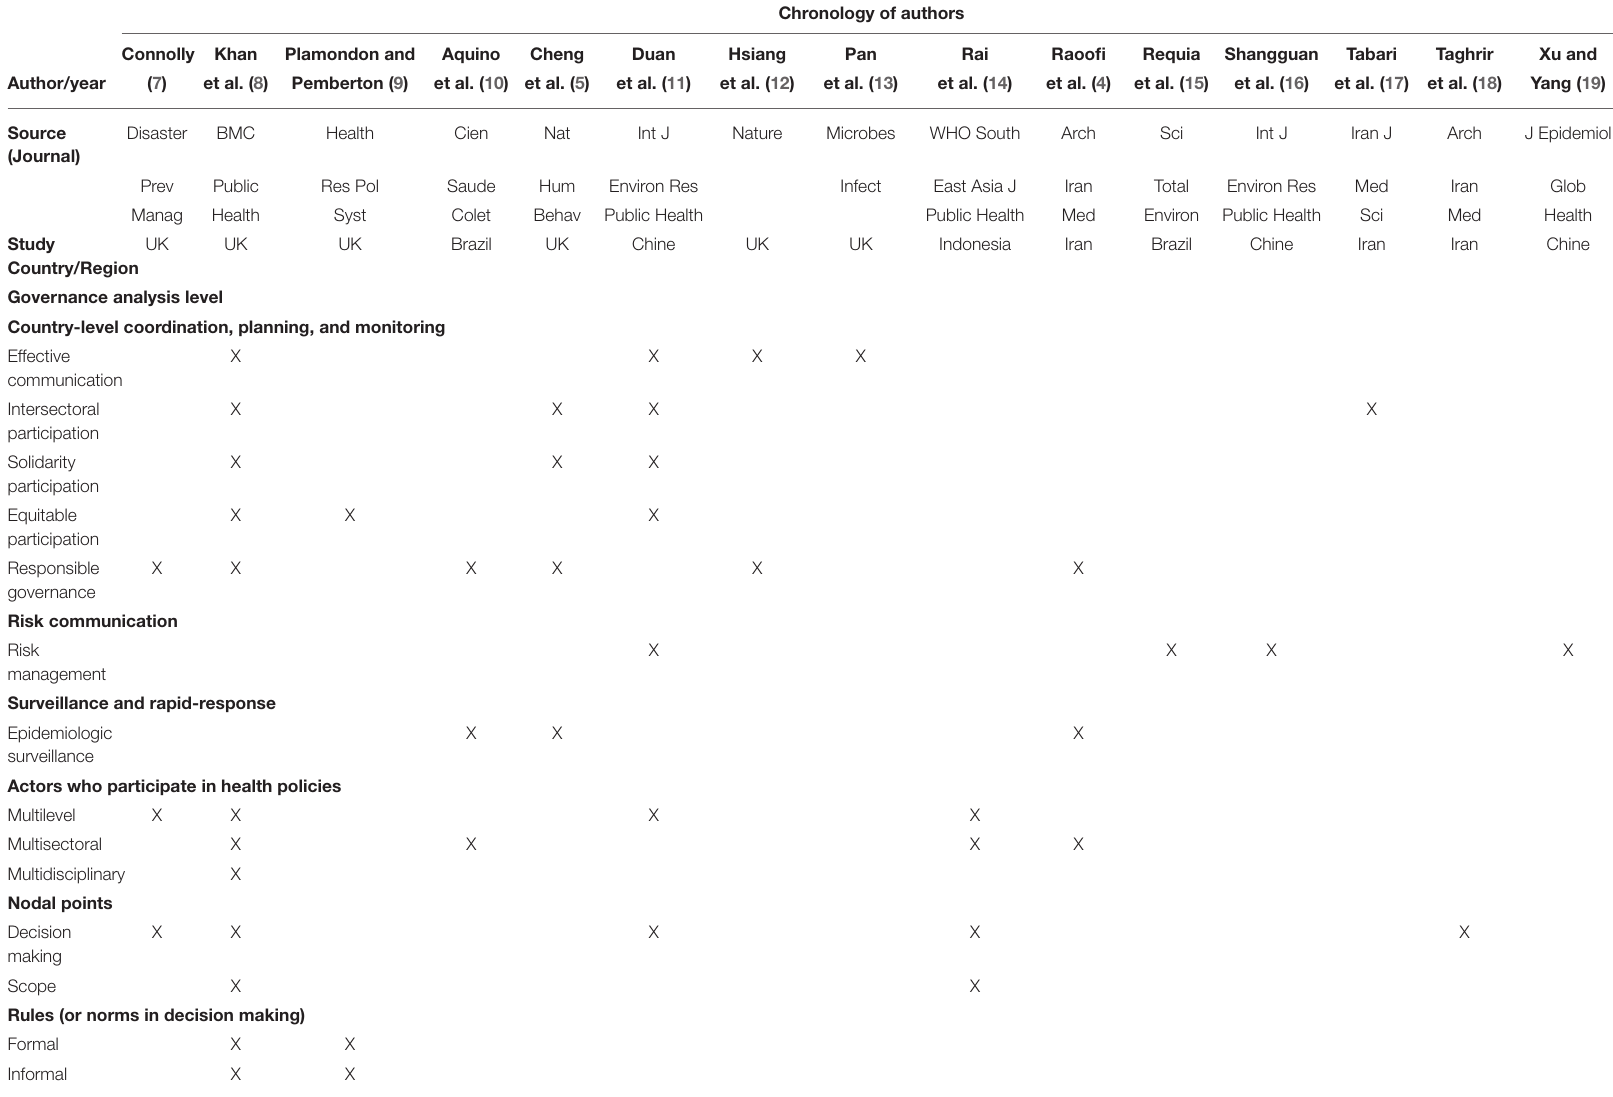
TABLE 1 | Classification of the articles by governance analysis level on health policies in the face of the health